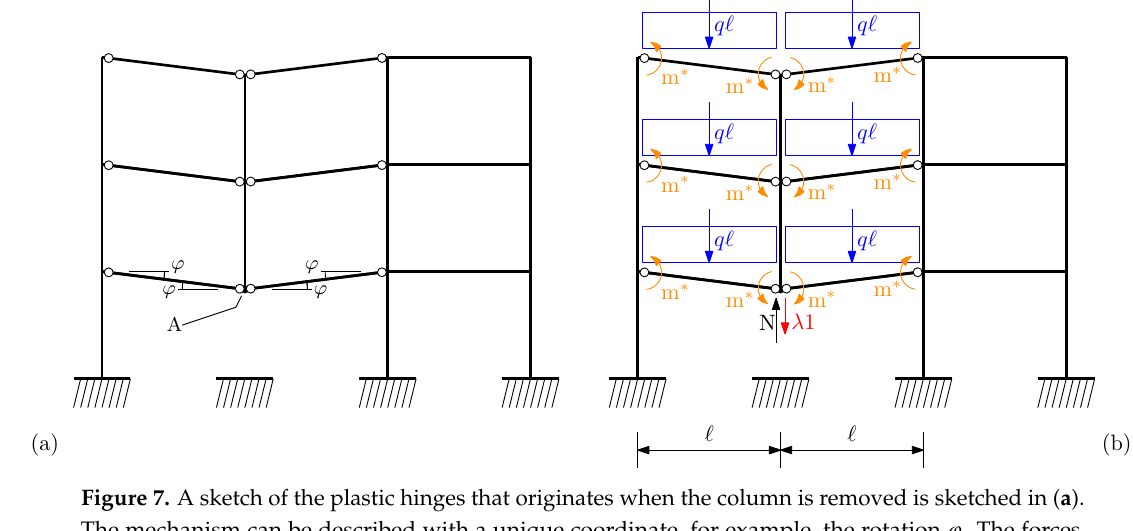
Figure 7. A sketch of the plastic hinges that originates when the column is removed is sketched in ( a ). The mechanism can be described with a unique coordinate, for example, the rotation ϕ . The forces applied on the structure onto which the virtual work principle (VWP) is applied is depicted in ( b